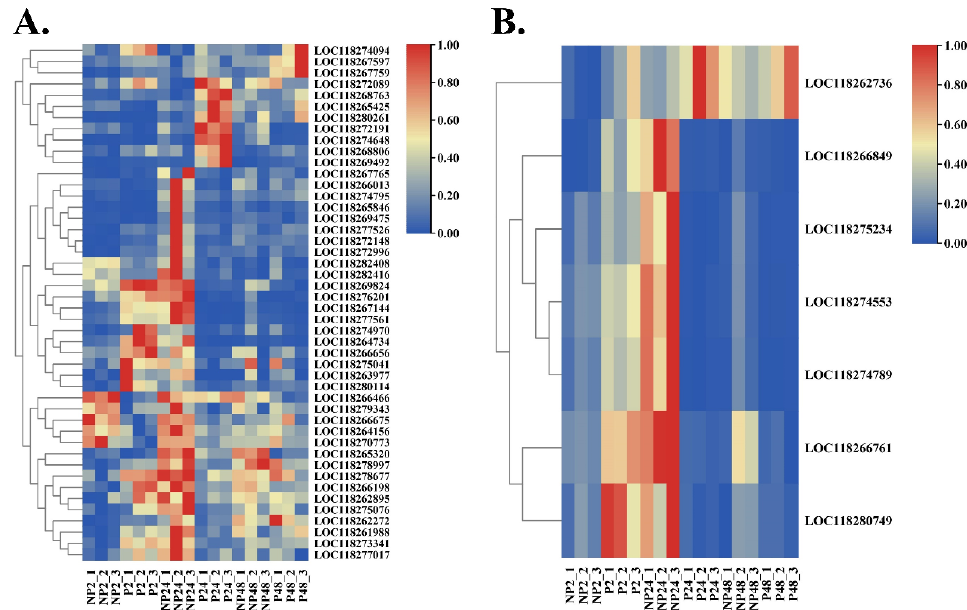
Figure 5. Expression profiles of DEGs involved in host metabolism and immunity. ( A ) Expression profiles of metabolism-related genes in host FAW upon M. manilae parasitization. ( B ) Expression profiles of immune-related genes in host FAW upon M. manilae parasitization. The higher and lower expression levels are respectively shown in red and blue colors based on the log 2 (FPKM) values.